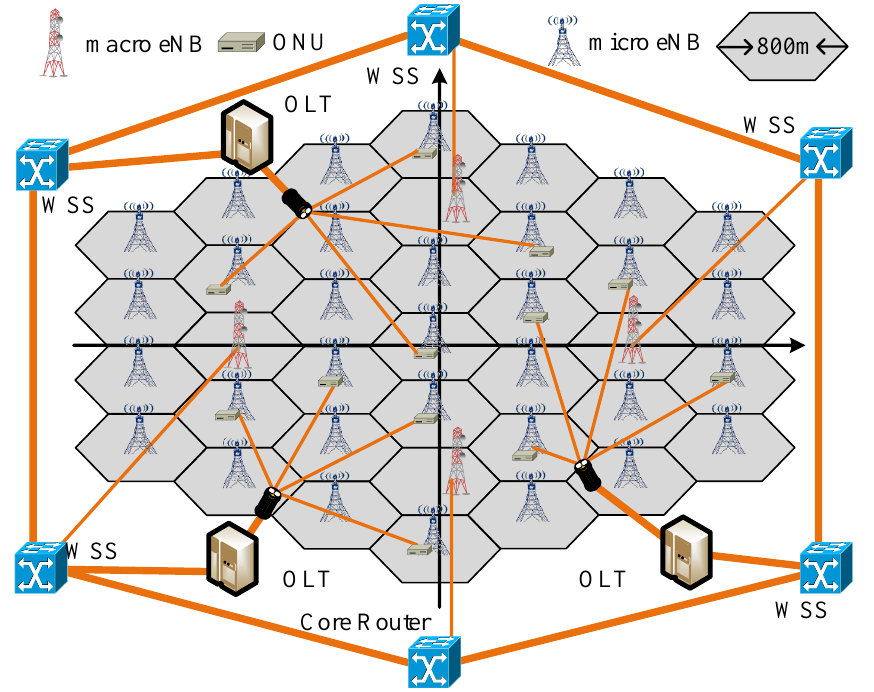
Figure 6. Optical access network simulated topology.